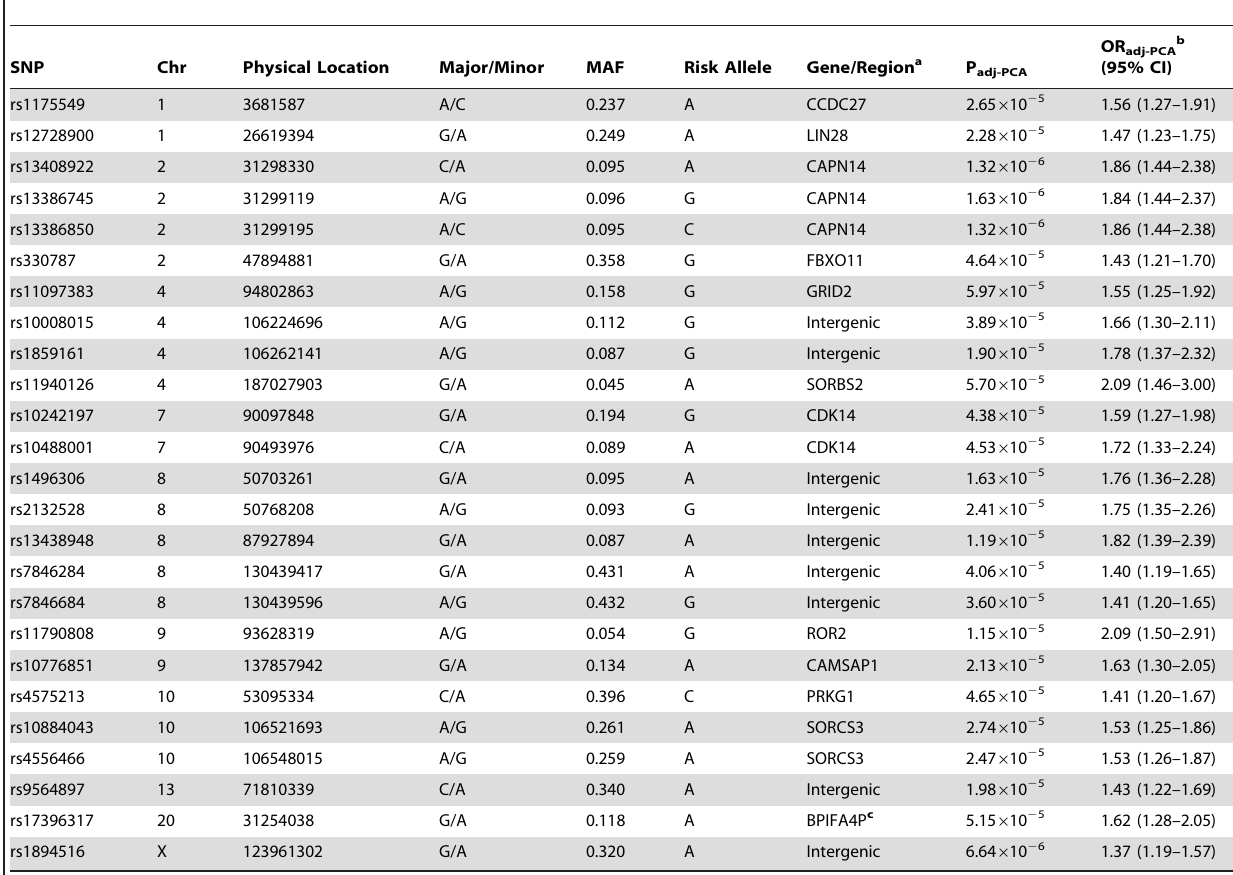
Table 1. Top 25 genotyped polymorphisms from the discovery GWAS carried out in the Raine Study ordered by chromosome and physical location with analysis adjusted for the first two PCs using